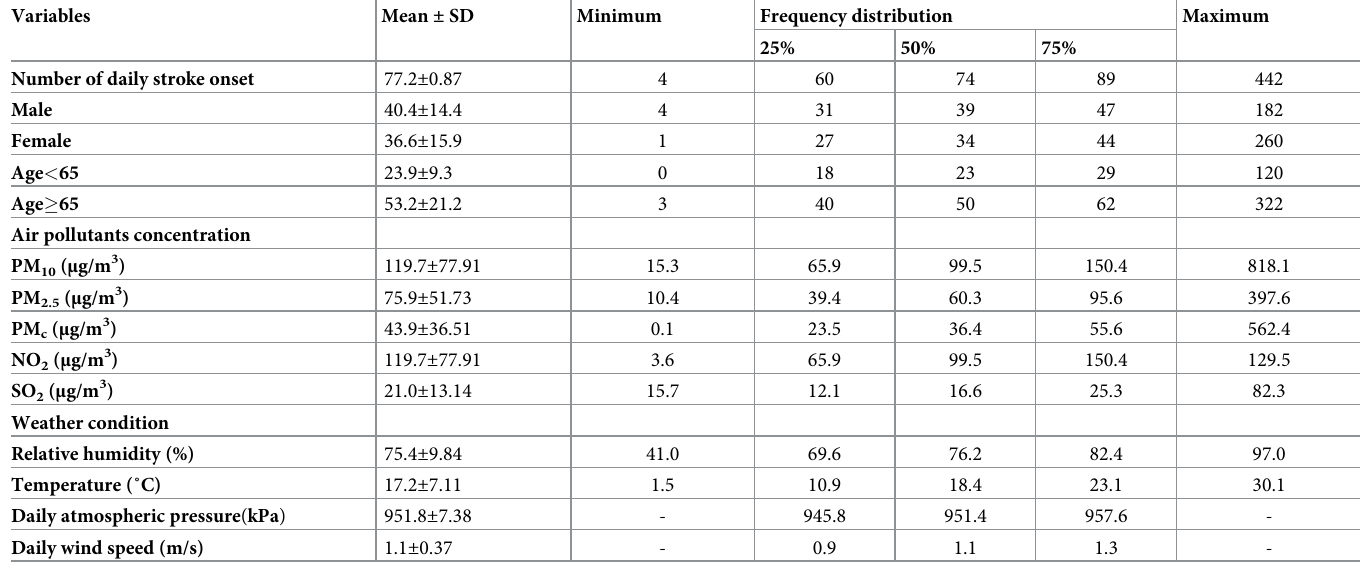
Table 1. Distribution of numbers of daily stroke onset, air pollutants concentration and meteorological conditions in Chengdu, China (2013–2015).